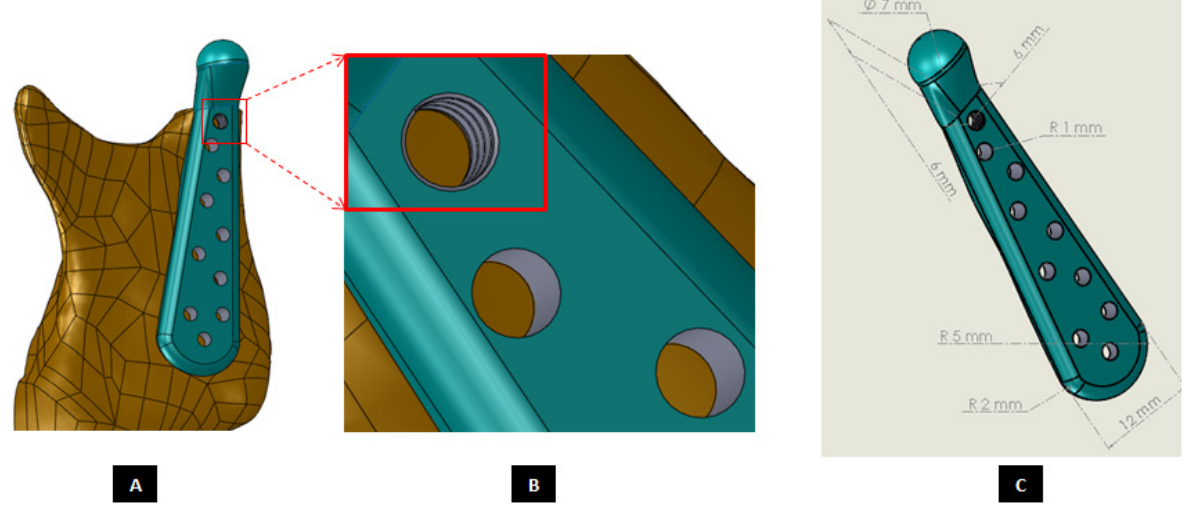
Figure 7. Custom-designed condylar/ramus component of the TMJ total joint replacement prosthesis for left TMJ of a patient. ( A ) Shows lateral view of the implant with screw holes. ( B ) Shows an enlarged view of the screw holes, where the first superiorly located screw hole has threads to incor- porate locking-plate-screw mechanism by engaging the threads on the head of a locking screw de- scribed in the text. ( C ) Shows engineering dimensions of this patient-specific implant.